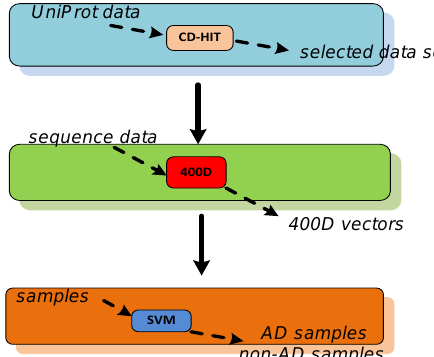
Figure 1. The flow chart of AD identification.